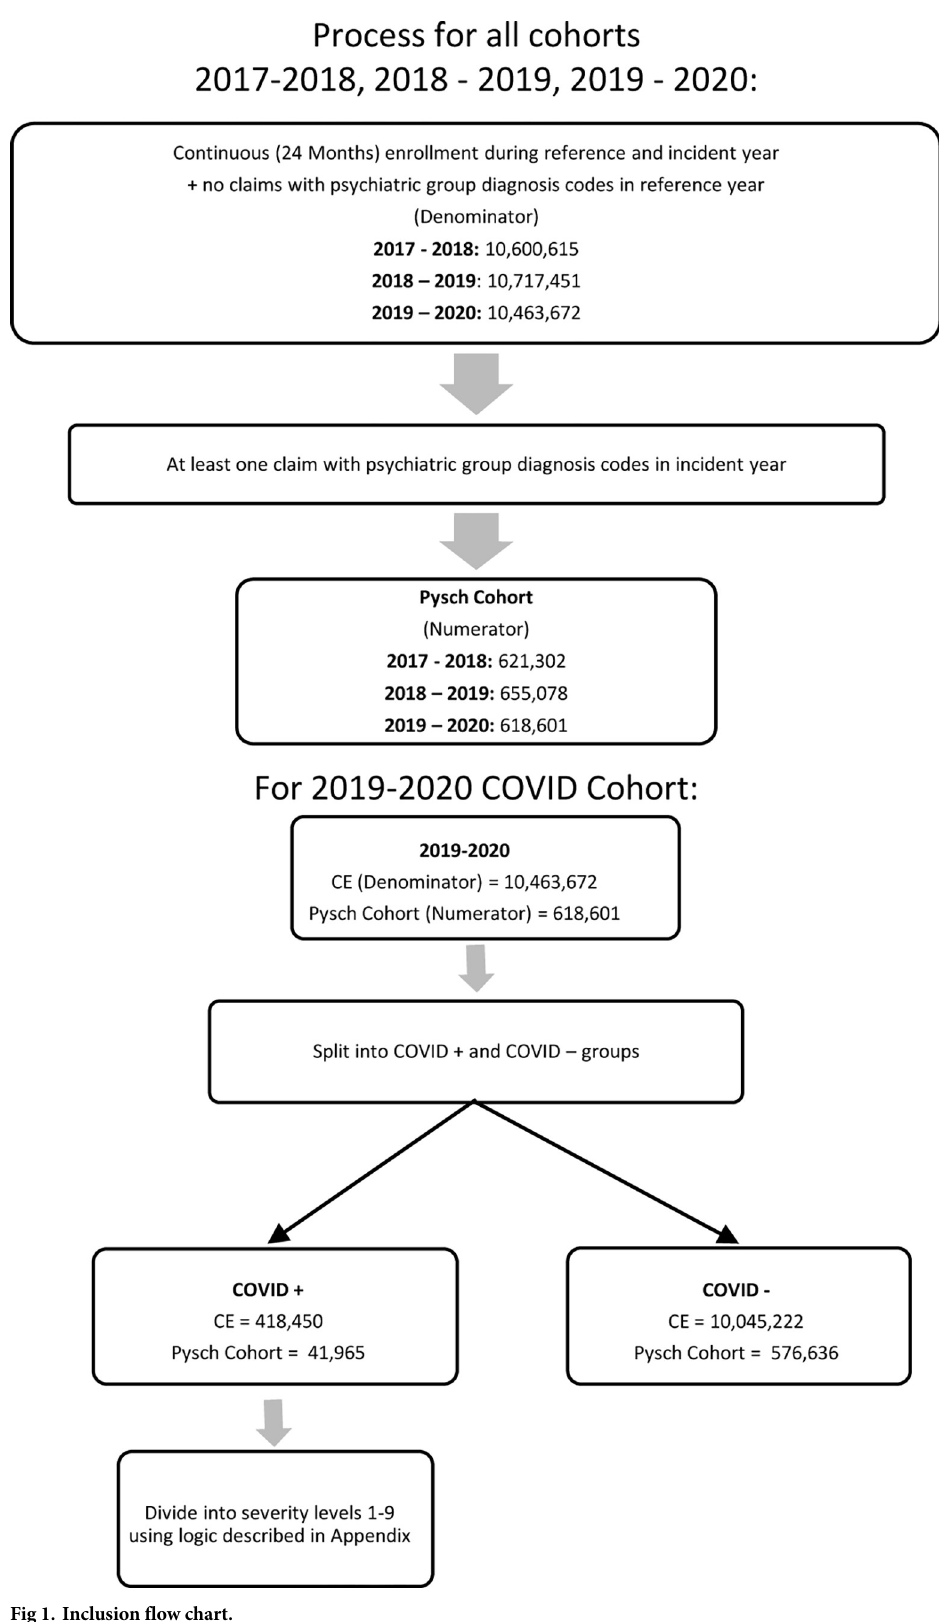
Fig 1. Inclusion flow